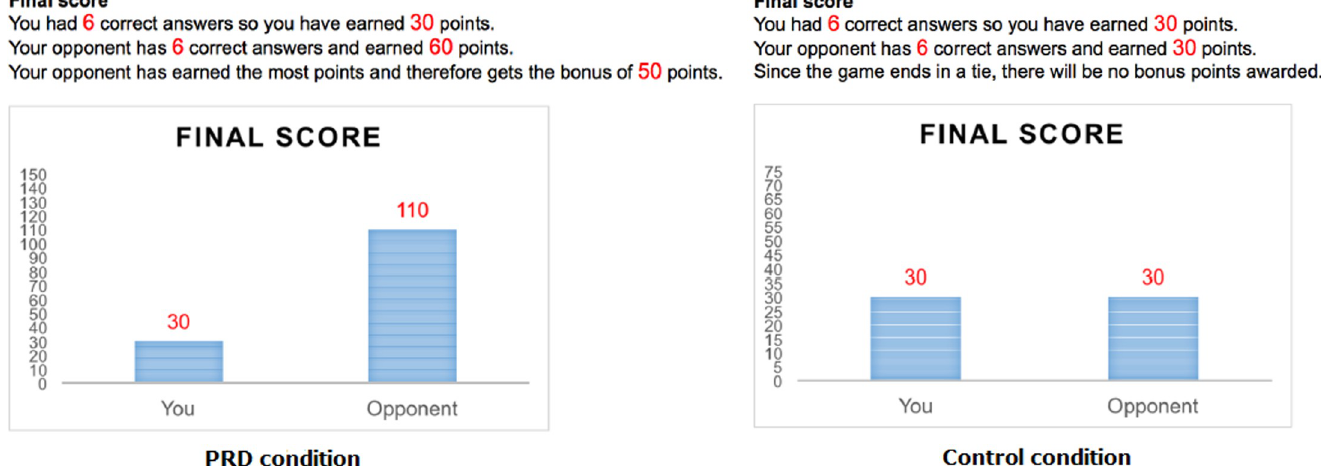
Fig 1. Screens of the final scores of the PRD condition and the control condition, as part of the PRD manipulation. The points earned did not objectively differ between conditions, conditions differed in the idea that the opponent earned much more (PRD condition) or just the same (control condition) for the same number of correct